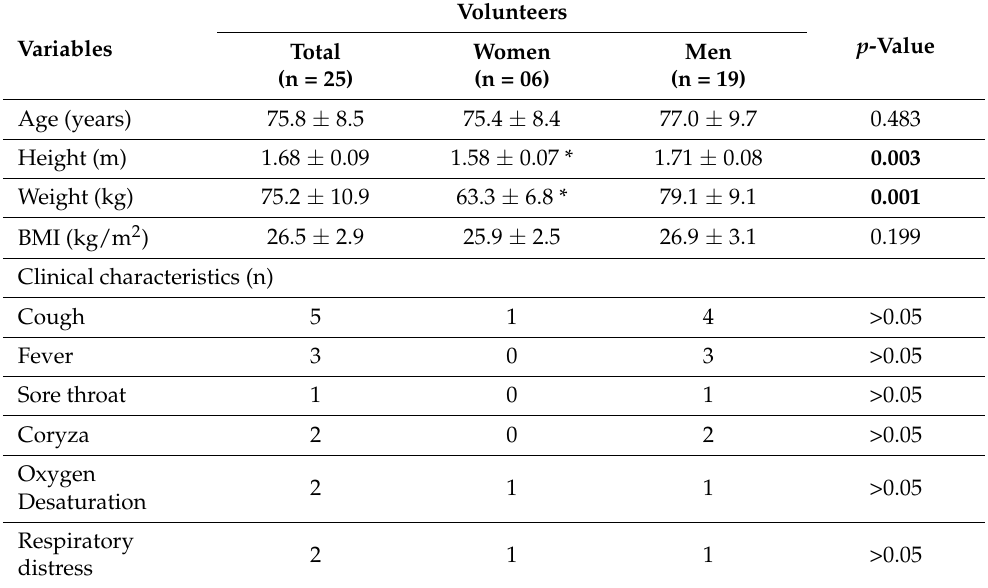
Table 1. Anthropometric data presented as mean and standard deviation (X_ ± _SD), and also the clinical characteristics (n) presented by the volunteers during the MO